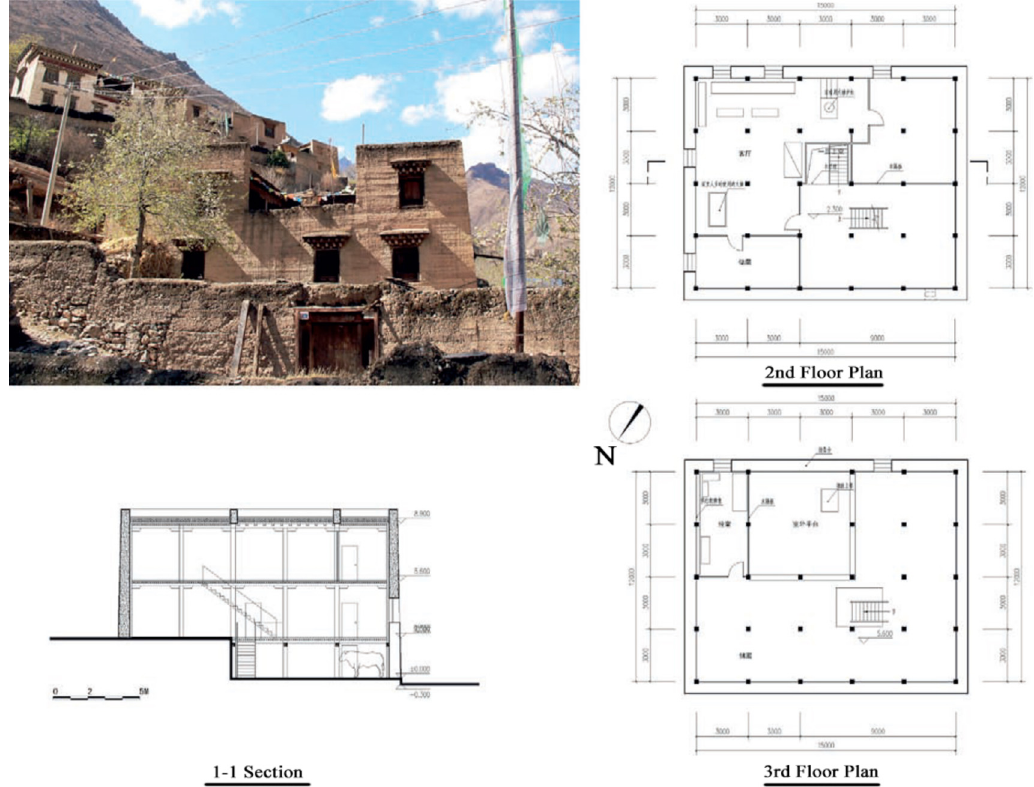
Fig. 5. Lurong Nima's dwelling in Yuejin Village, Dongwang Township. Table 2. Technological factors in building traditional Tibetan dwellings in Shangri-La. Building